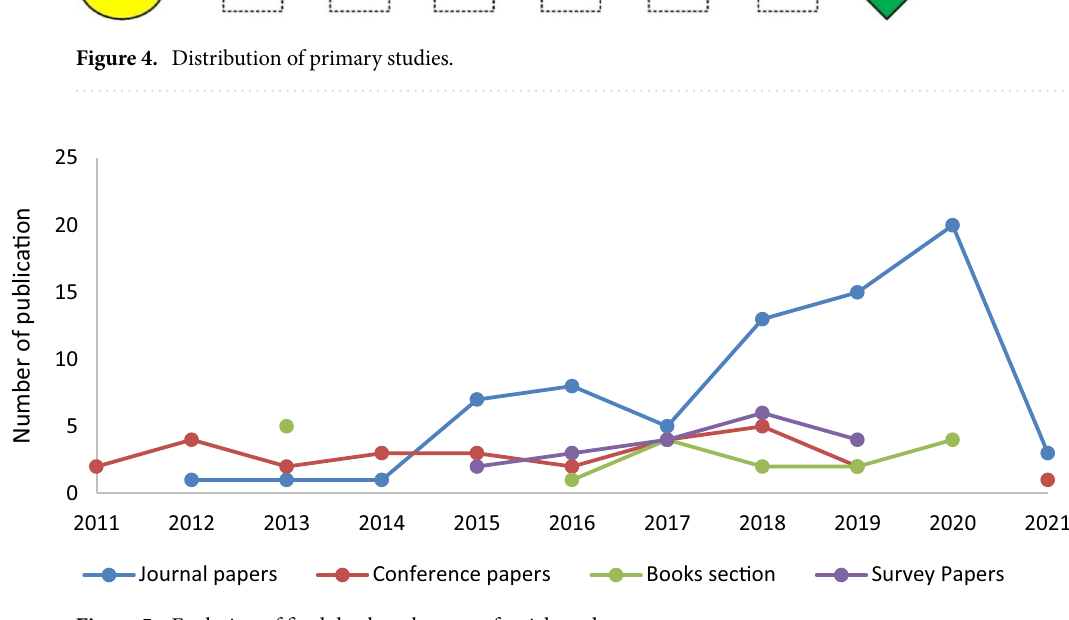
Figure 5. Evolution of final database by type of article and